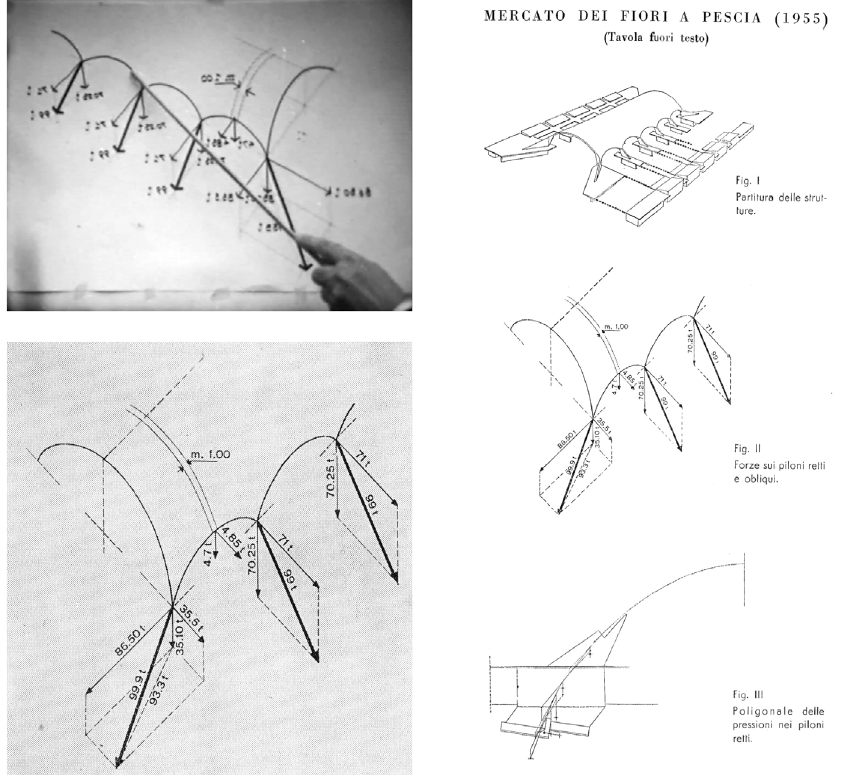
Fig. 7 Mercato dei Fiori, Pescia: structural 3D model of the vault (author: Alice